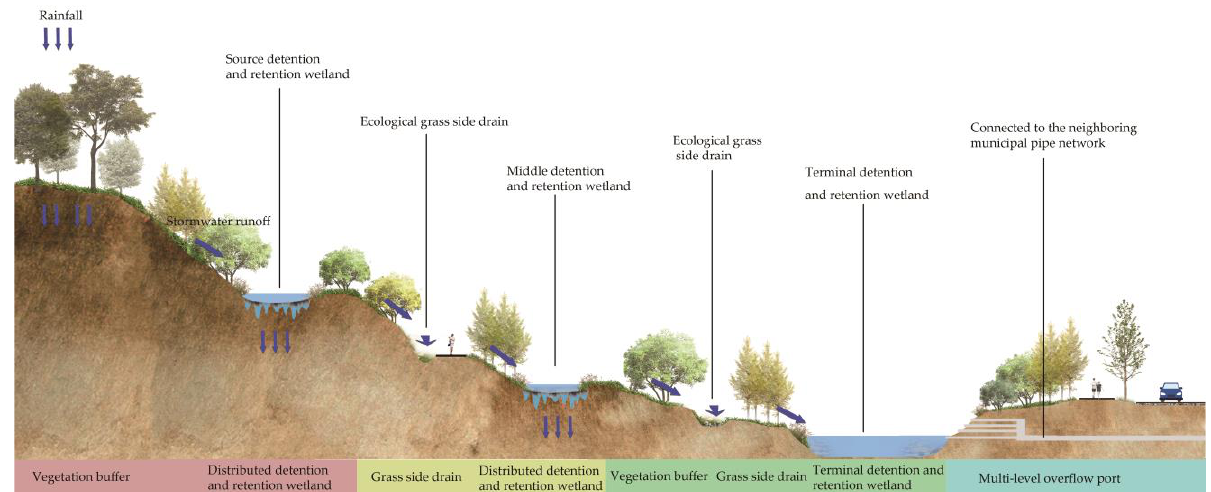
Figure 5. Schematic diagram of LID Scheme S.